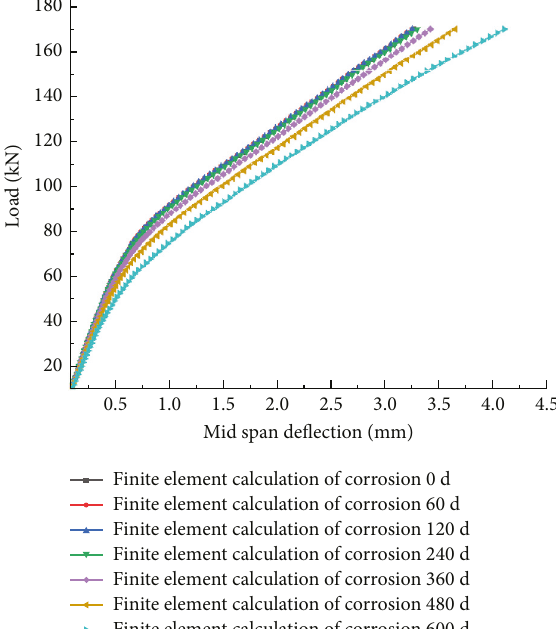
Figure 12: Load deflection